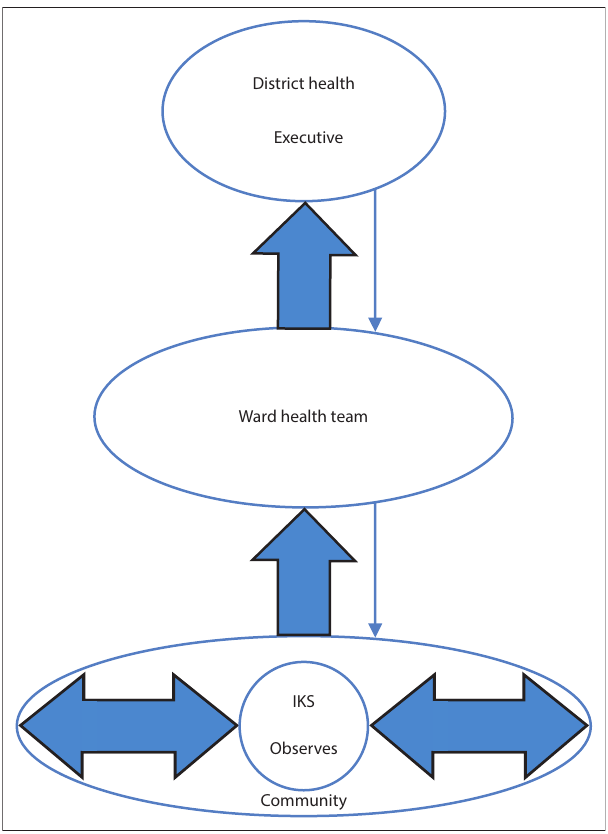
FIGURE 7: Generic structure of the community-based malaria early warning